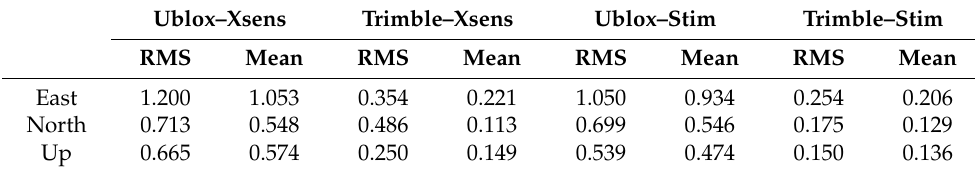
Table 5. RMS error and mean error (m) in east, north, and up directions—first field trial. Ublox–Xsens